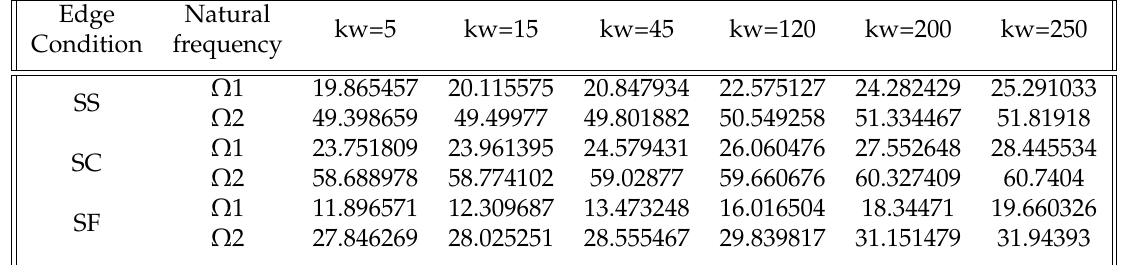
Table 5. Variation elastic foundation coefficient on natural